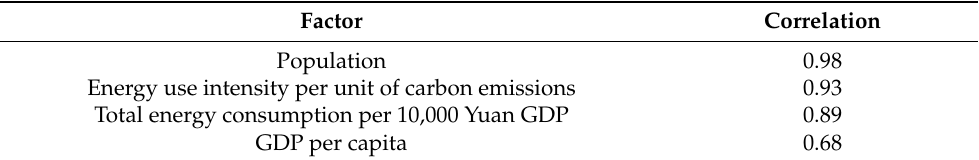
Table 10. Gray correlation analysis of carbon emissions and Kaya’s constant decomposition